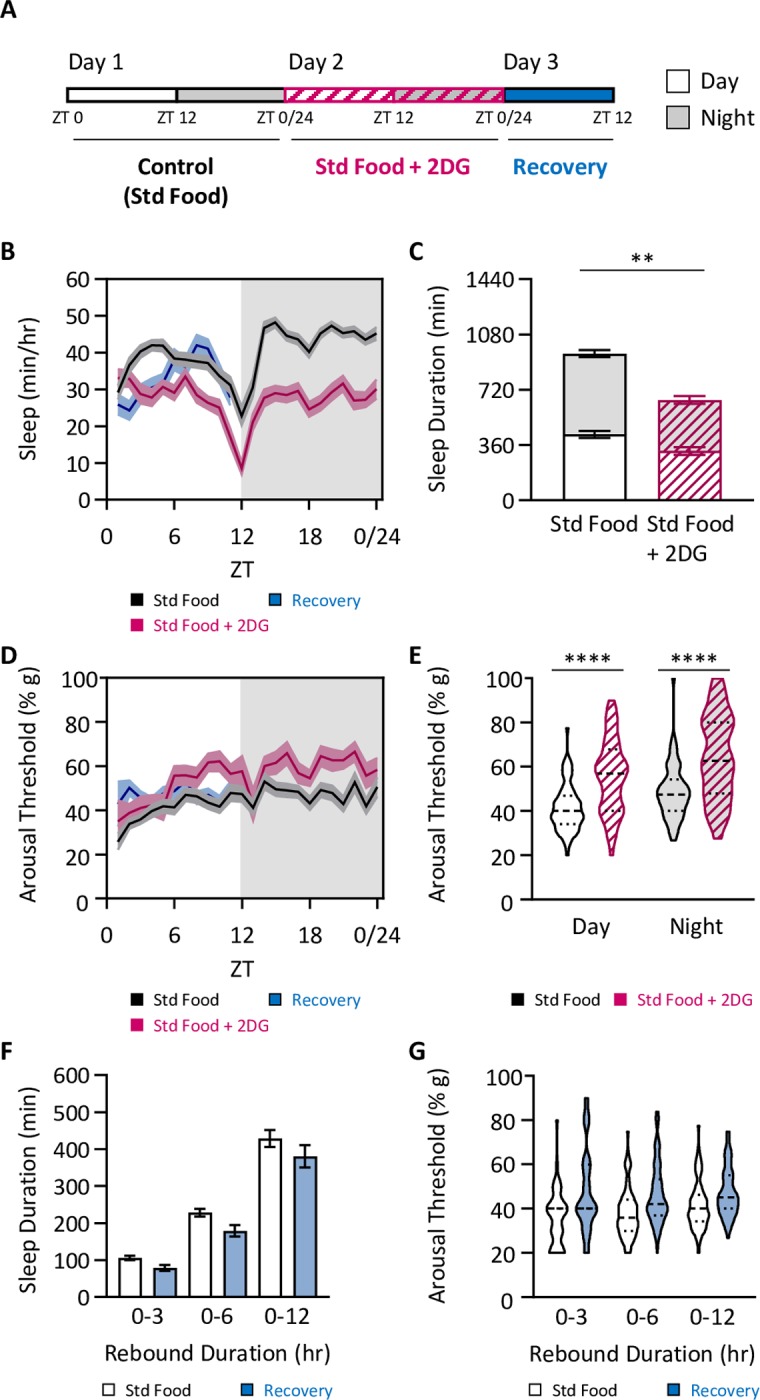
Inhibition of glycolysis phenocopies the yeast-dependent modulation of arousal threshold.(A) Total sleep and arousal threshold were assessed for 24 hrs on standard food (black outlined boxes), standard food + 2-deoxyglucose (2DG; pink outlined boxes with hatches), and then when transferred back to standard food. (B) Sleep profiles. (C) Sleep duration decreases when 2DG is included in the diet (two-way ANOVA: F1,190 = 38.77, P<0.0001), and occurs during both the day (P = 0.0040) and night (P<0.0001). (D) Profile of arousal threshold. (E) Arousal threshold significantly increases when 2-DG is included in the diet (REML: F1,111 = 71.07, P<0.0001, N = 46–51), and occurs during both the day (P<0.0001) and night (P<0.0001). (F-G) Measurements of homeostatic rebound following 24 hrs of 2DG feeding were assessed in 3-, 6-, and 12-hr increments. (F) Although there is a significant effect of treatment on sleep duration (two-way ANOVA: F1,285 = 7.943, P = 0.0052), post hoc analyses revealed no evidence of a homeostatic rebound for any timepoint measured (0–3 hrs: P = 0.6399; 0–6 hrs: P = 0.1582; 0–12 hrs: P = 0.1661). (G) Although there is a significant effect of treatment arousal threshold (REML: F1,121 = 5.426, P<0.0231, N = 46–51), post hoc analyses revealed no evidence of a homeostatic rebound for any timepoint measured (0–3 hrs: P = 0.3274; 0–6 hrs: P = 0.0822; 0–12 hrs: P = 0.4670). For profiles, shaded regions indicate +/- standard error from the mean. White background indicates daytime, while gray background indicates nighttime. For sleep measurements, error bars represent +/- standard error from mean. For arousal threshold measurements, the median (dashed line) as well as 25th and 75th percentiles (dotted lines) are shown. ** = P<0.01; **** = P<0.0001.